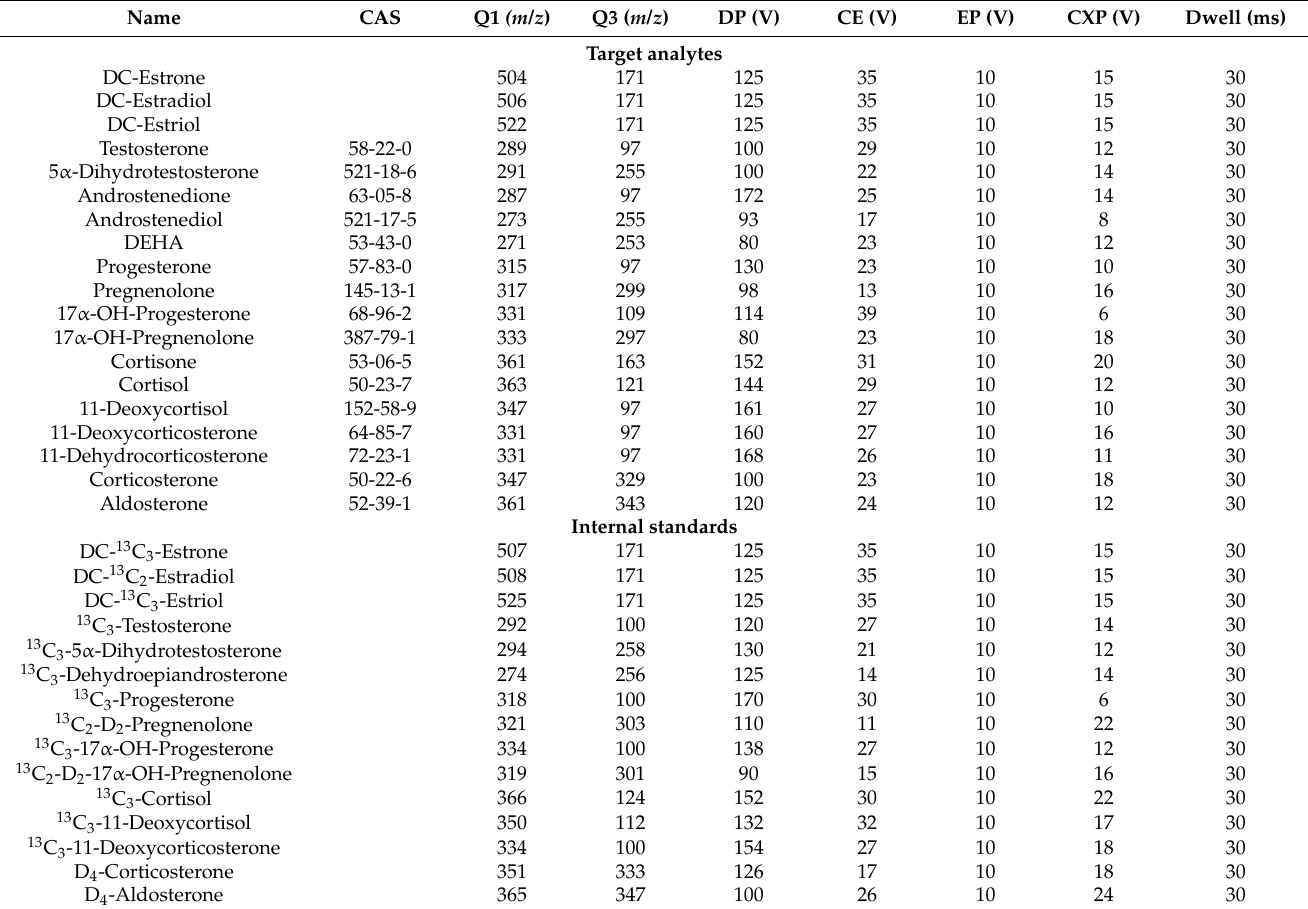
Table 1. Target analytes (19 steroid hormones), isotopically labeled internal standards, and their MRM parameters. MRM parameters include precursor ion (Q1), product ion (Q3), declustering potential (DP), entrance potential (EP), collision energy (CE), collision cell exit potential (CXP), and dwell